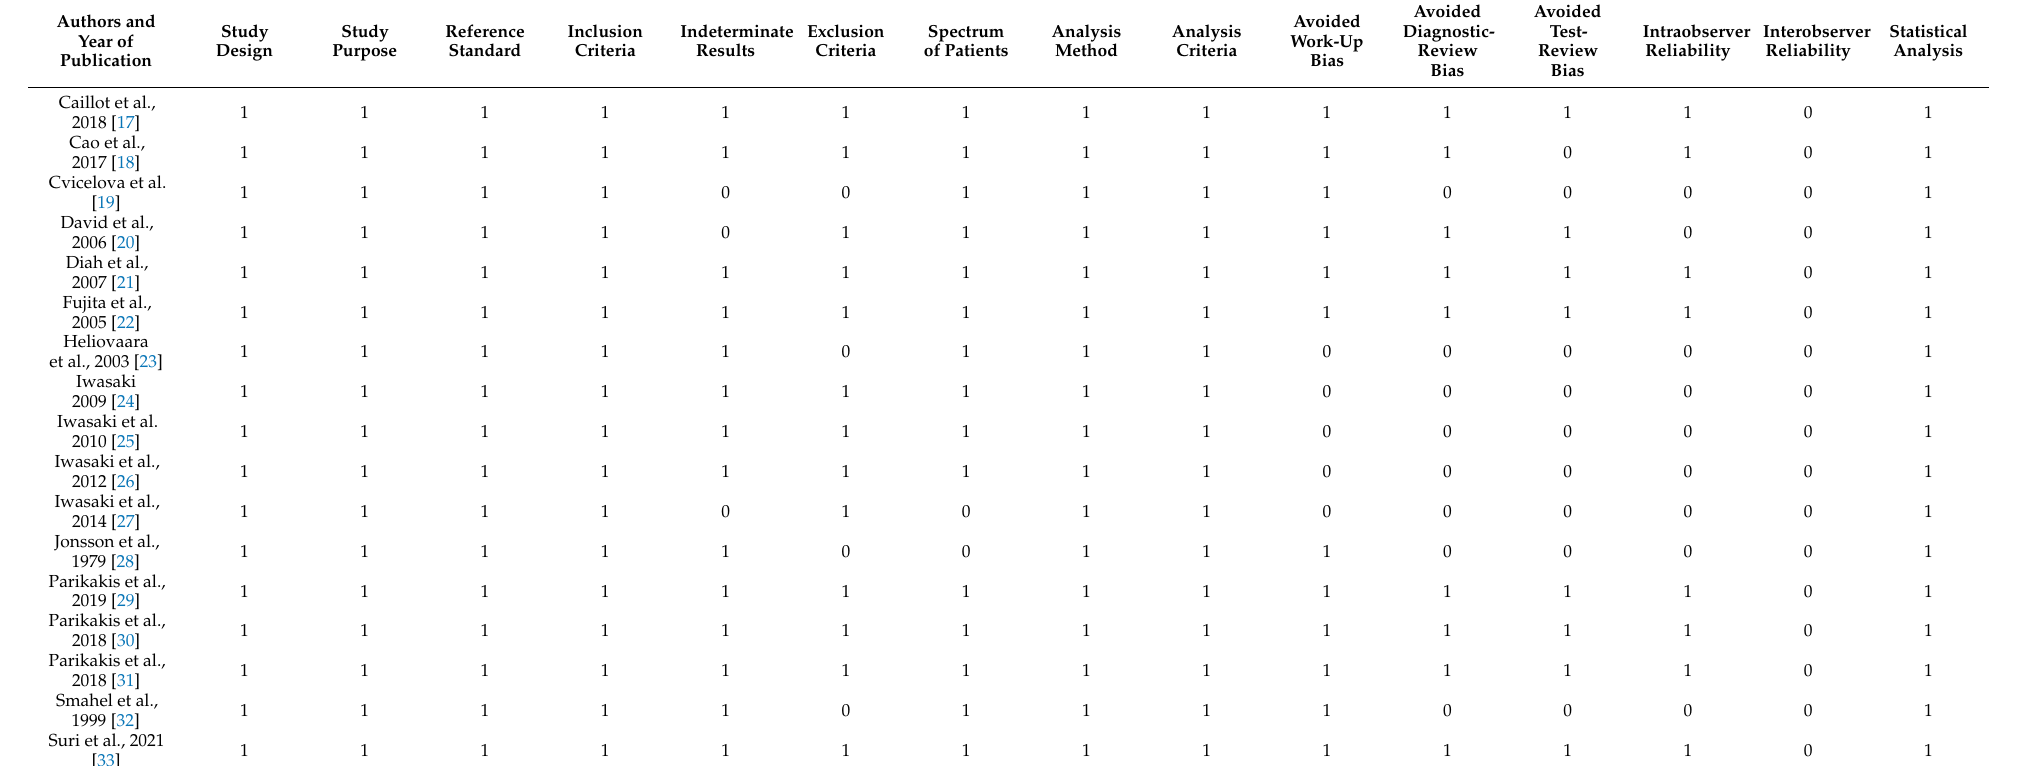
Table 2. Characteristics—according to Arrive’ scale for radiologic examinations